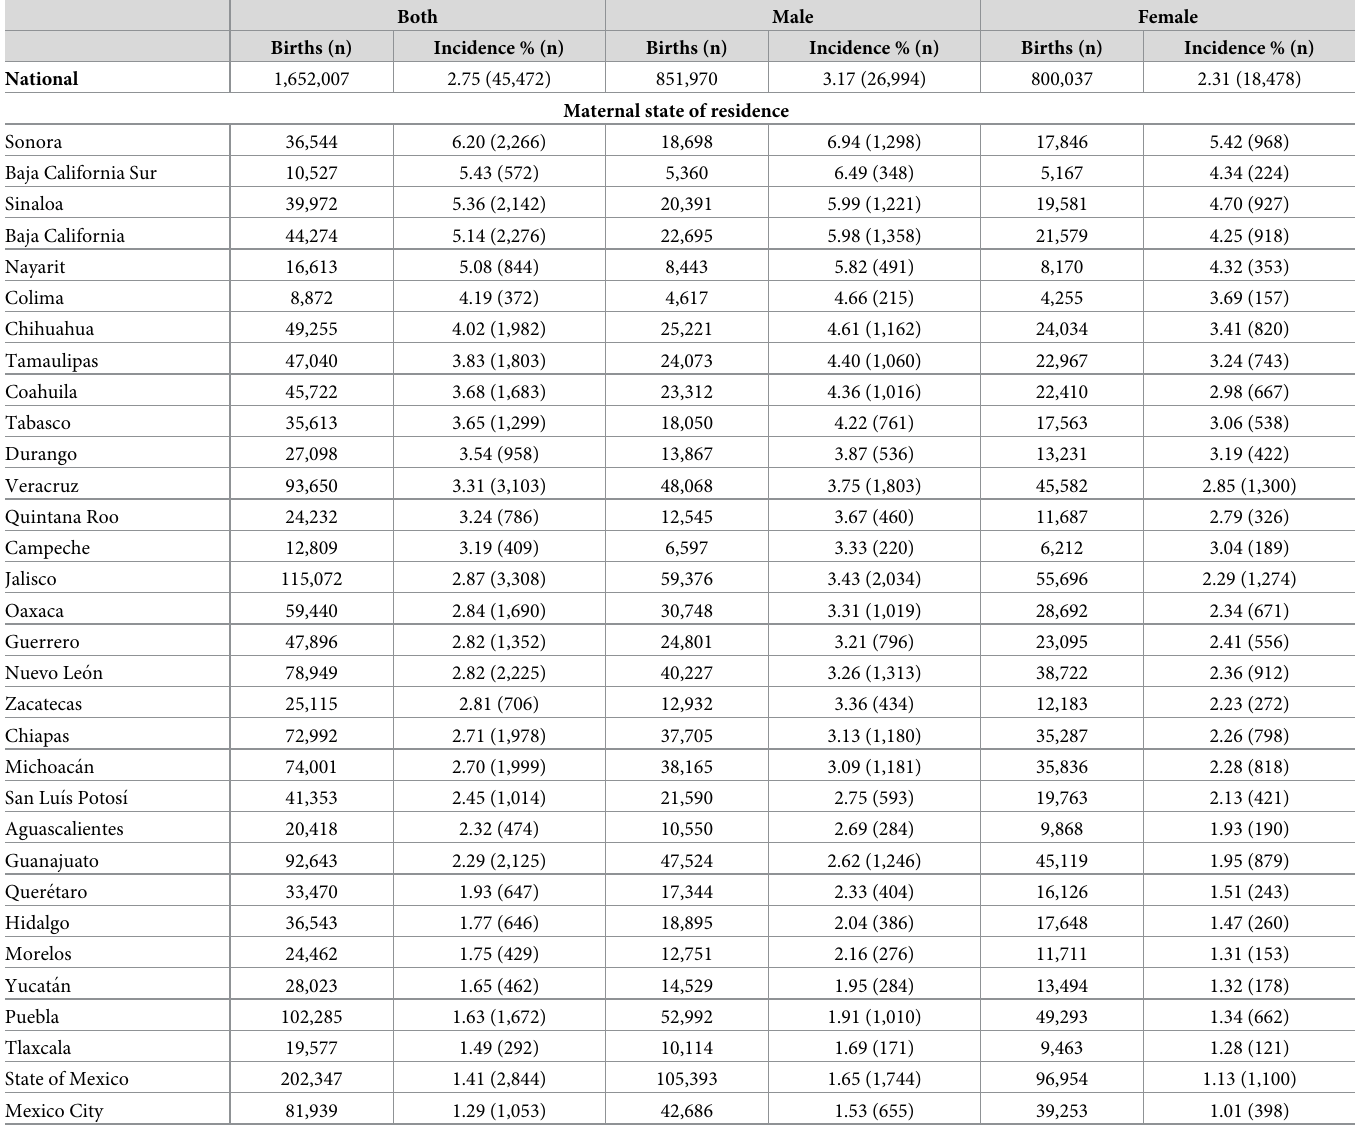
Table 1. National and state incidence of fetal macrosomia, Mexico 2020.